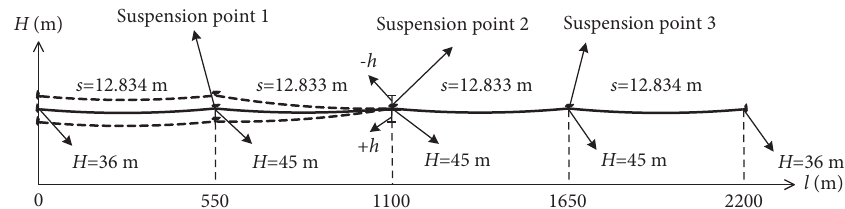
Figure 2: Calculation sketch of the transmission line